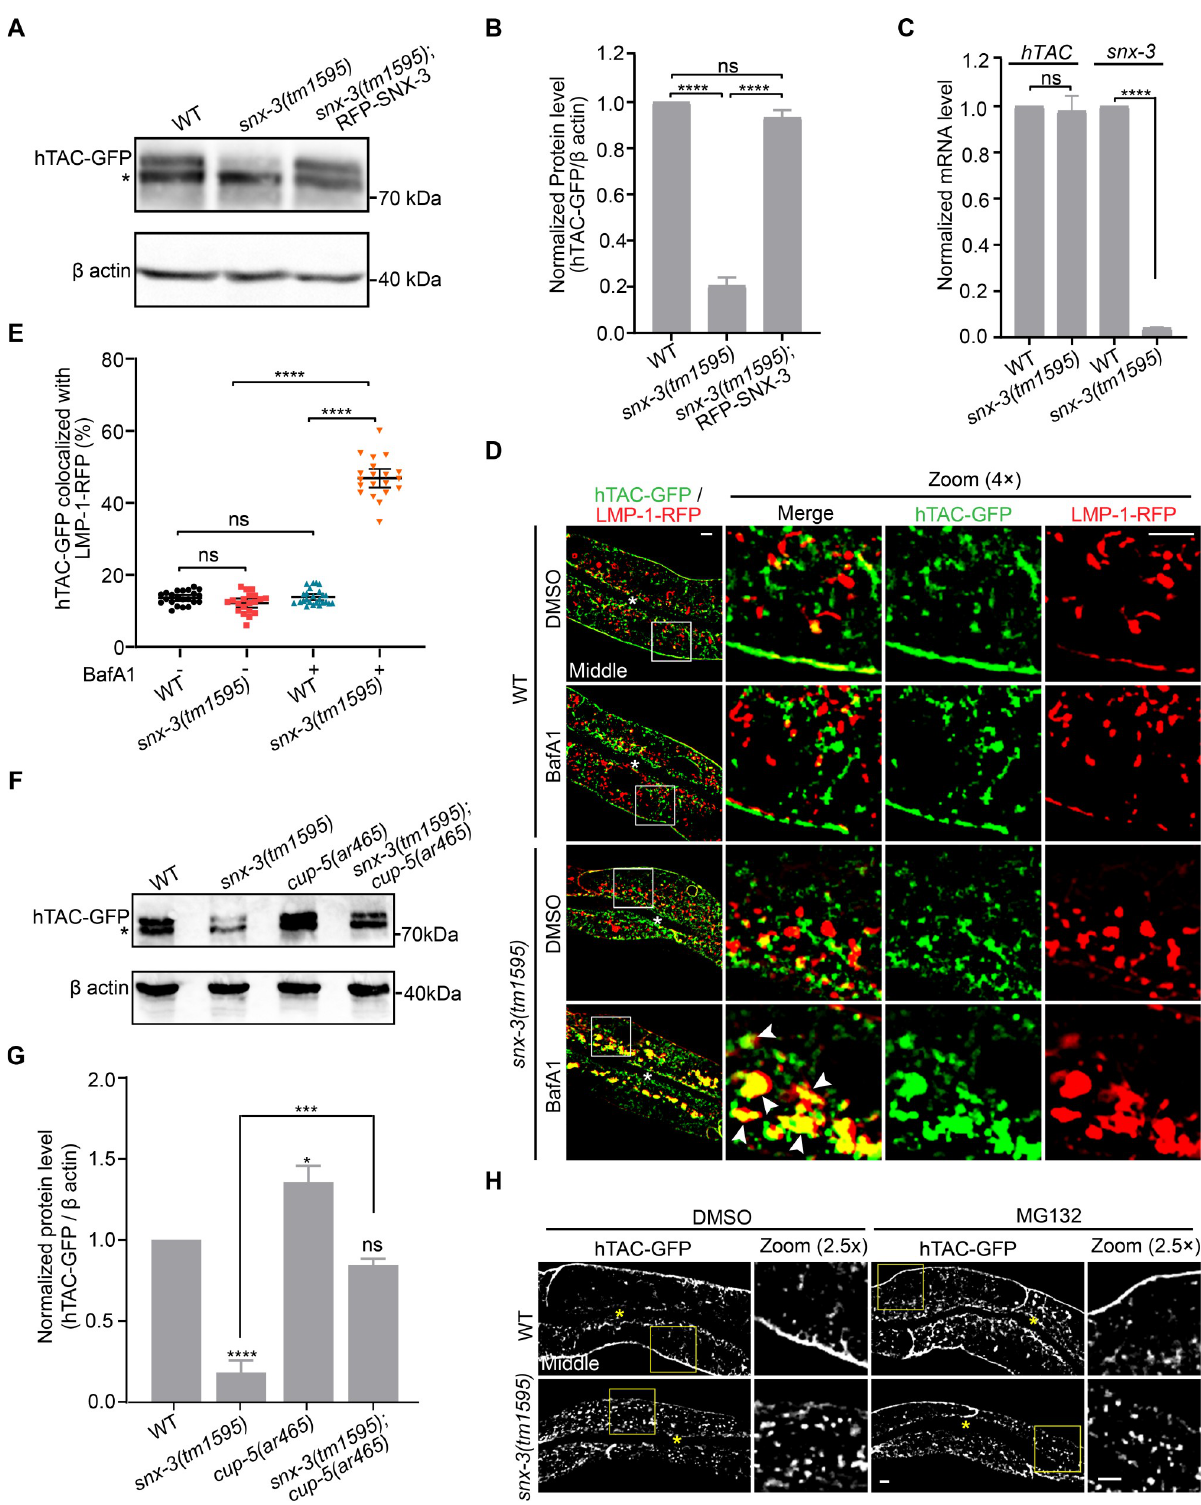
Fig 3. hTAC is efficiently degraded in the intestinal lysosome of snx-3(tm1595) mutants. (A,B) Western blot showed the hTAC-GFP level in snx-3 (tm1595) mutants was significantly reduced compared with WT animals, and the reduction of hTAC-GFP level was reversed by re-expression of RFP-SNX-3 driven by intestine specific vha-6 promoter. The lower band depicted by the asterisk is thought to represent non-specific antibody binding